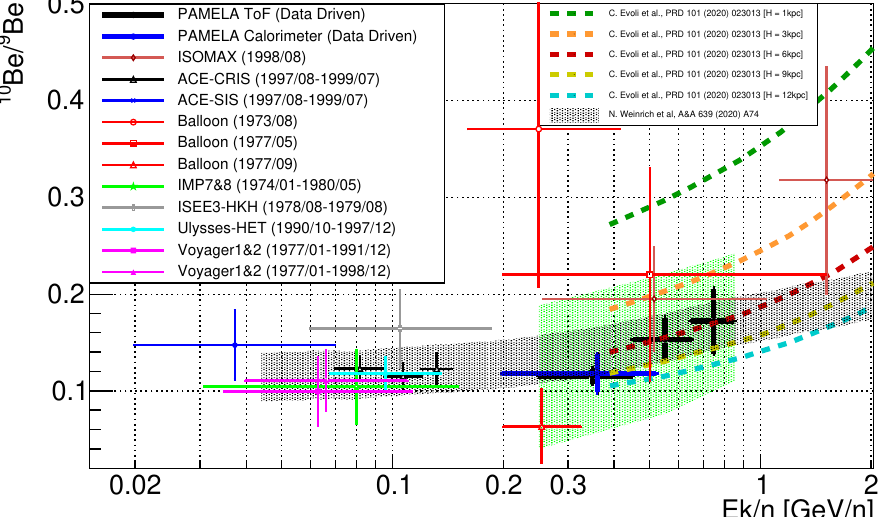
Figure 8. Results of the data-driven measurement of the 10 Be/ 9 Be ratio compared with previous experimental results and theory expectations: [1] (dashed lines) and [4] (hatched region). The green shaded contour is the systematic uncertainty inferred for the data-driven